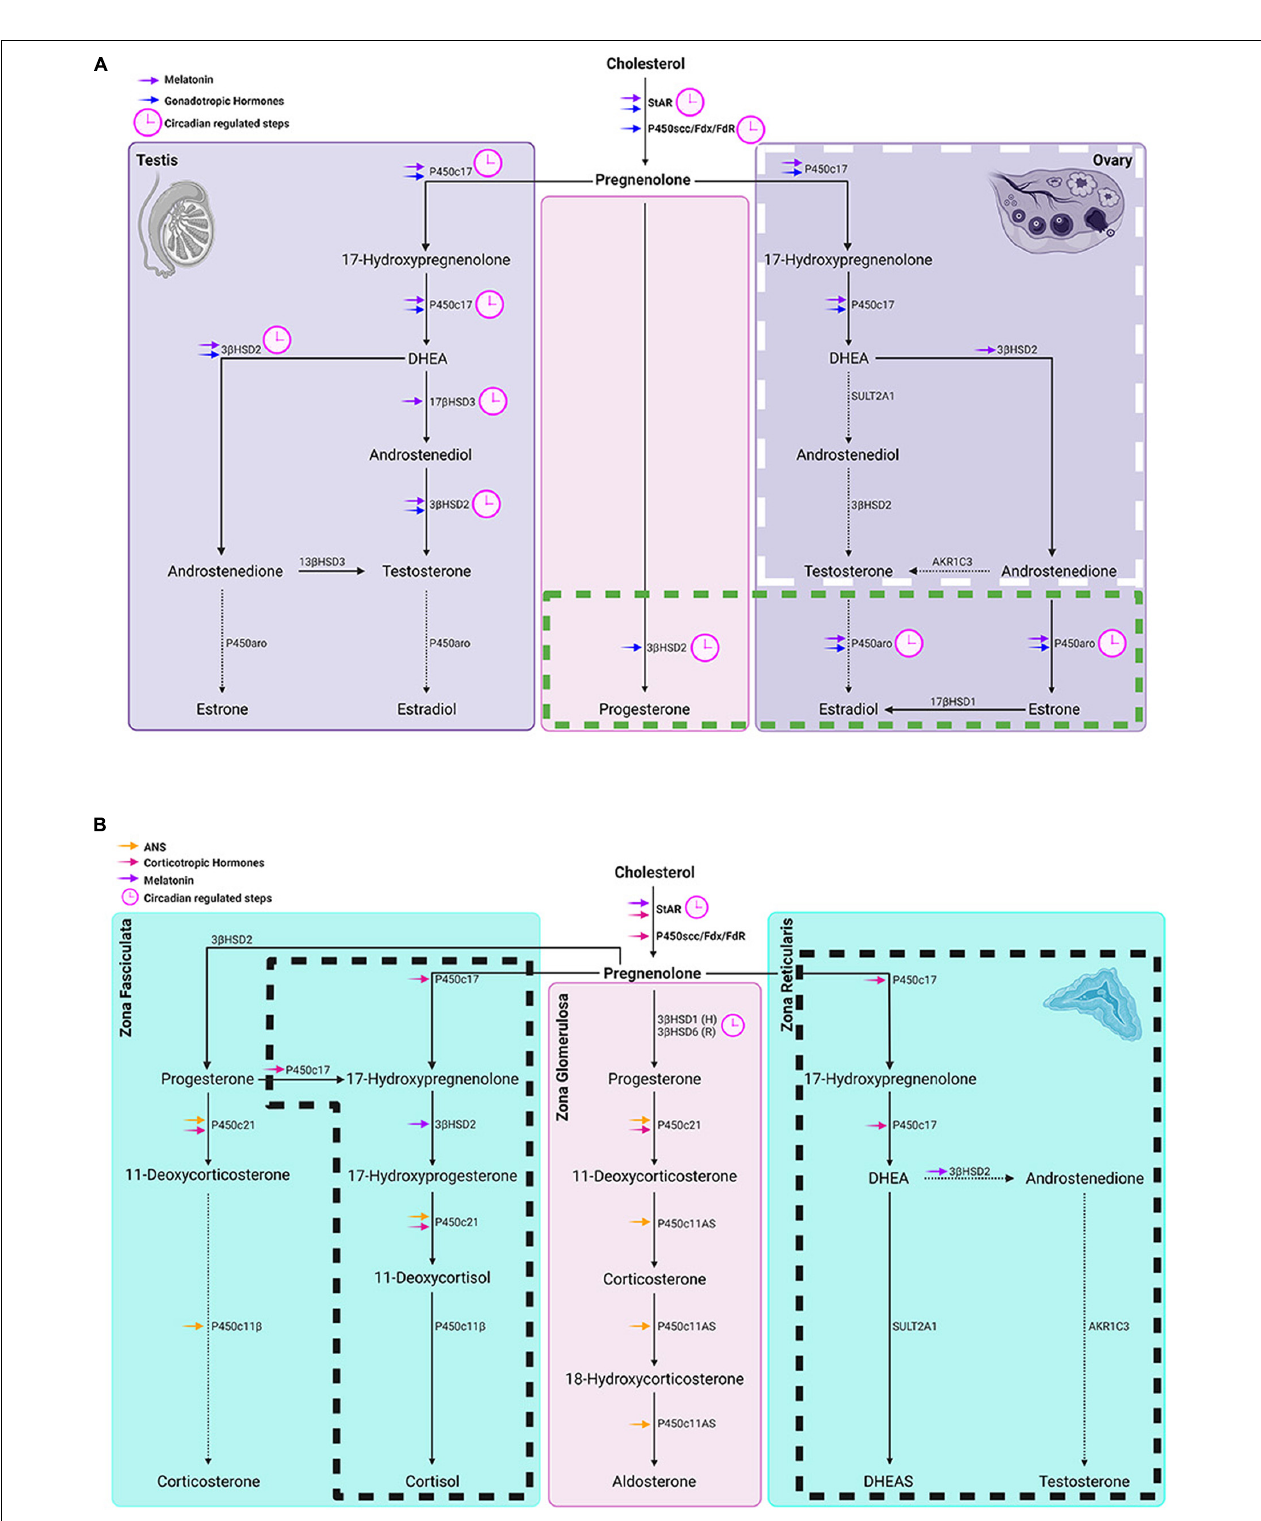
FIGURE 4 | Circadian timing system regulation of gonadal and adrenal steroidogenesis. (A) Left and right panels show steroidogenic pathways in the testes and ovaries respectively while the middle panel represents steroidogenic pathways common to both glands. In the ovary, the box with white long-dashed border refers to thecal cell steroid synthesis and the one with a green short-dashed border indicates granulosa cell steroidogenesis. Symbols: Blue arrows = regulated by gonadotropic hormones. (B) From left to right panels: steroidogenic pathways in adrenal zona fasciculata, zona glomerulosa and zona reticularis respectively.